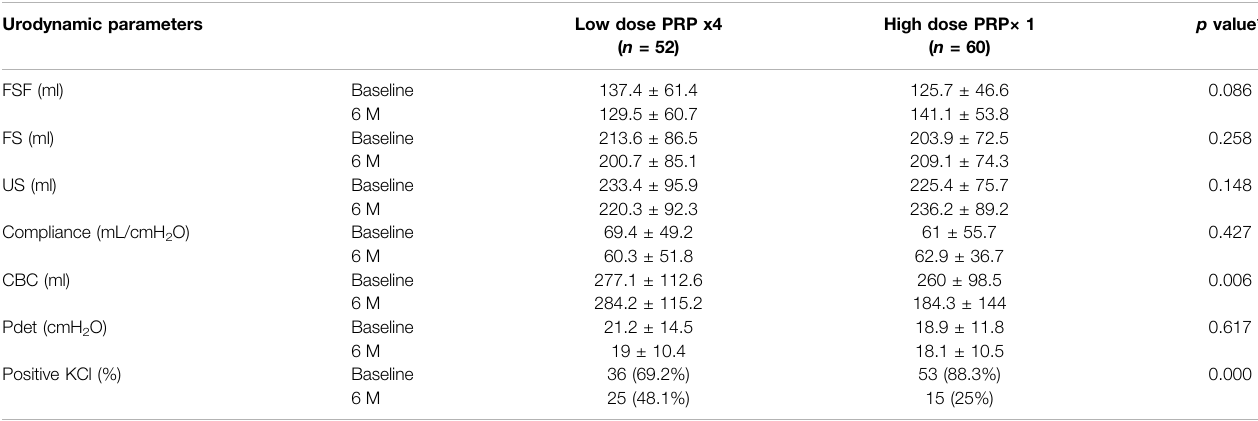
TABLE 6 | Changes in urodynamic parameters among treatment groups from baseline to end-points. Urodynamic